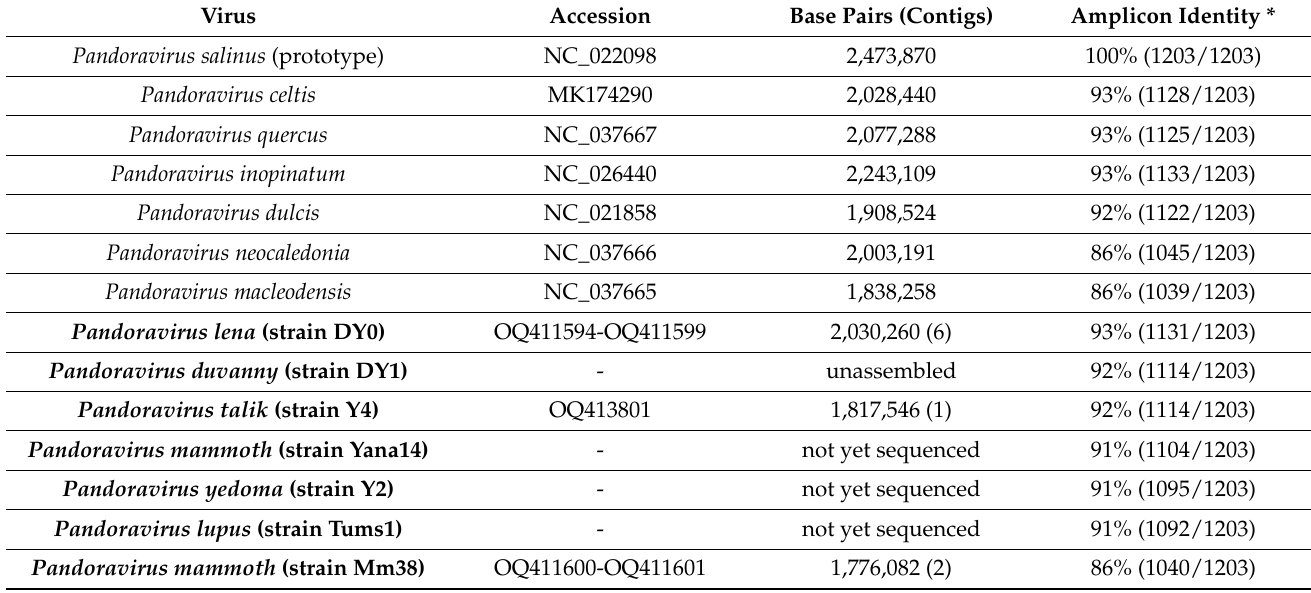
Table 3. PCR identification of previous and new Pandoravirus